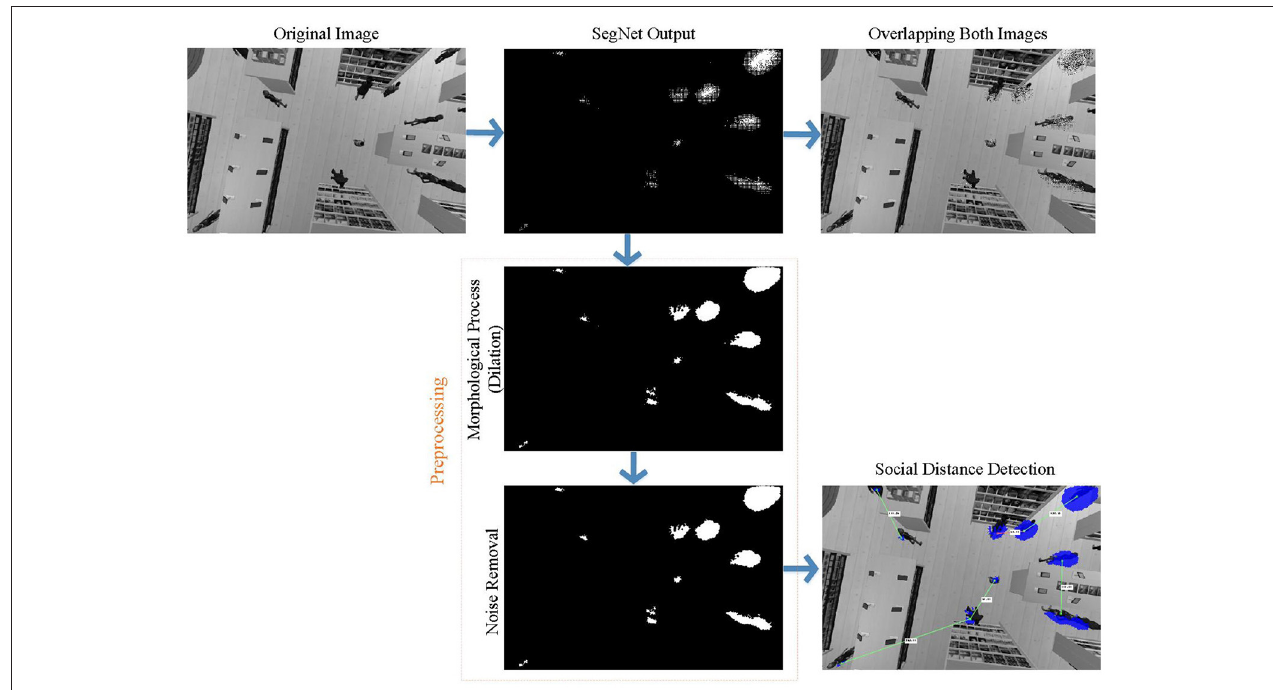
FIGURE 12 | Implementation of image preprocessing steps and social distance measurement in a frame of the shopping malls dataset (Trained SegNet misclassifies some pixels for the shopping mall dataset. These pixels are removed with preprocessing so that these defective pixels are ignored for social distance measurement. The mask image where noise is removed is used for social distance measurement. The distance line is red where social distance is violated).